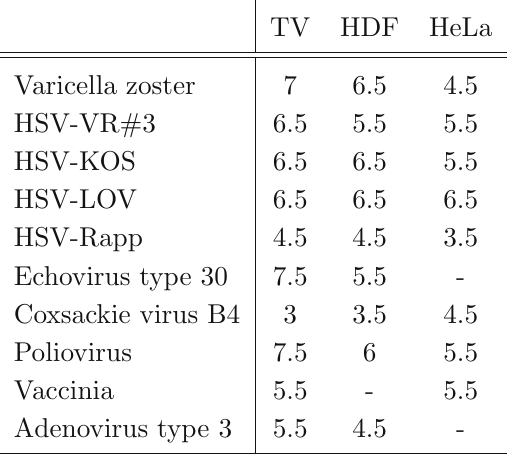
Table 1 CPE induced by different viruses (log of viral titer) on TV cells, human diploid embryonic fibroblast cells, and HeLa cell